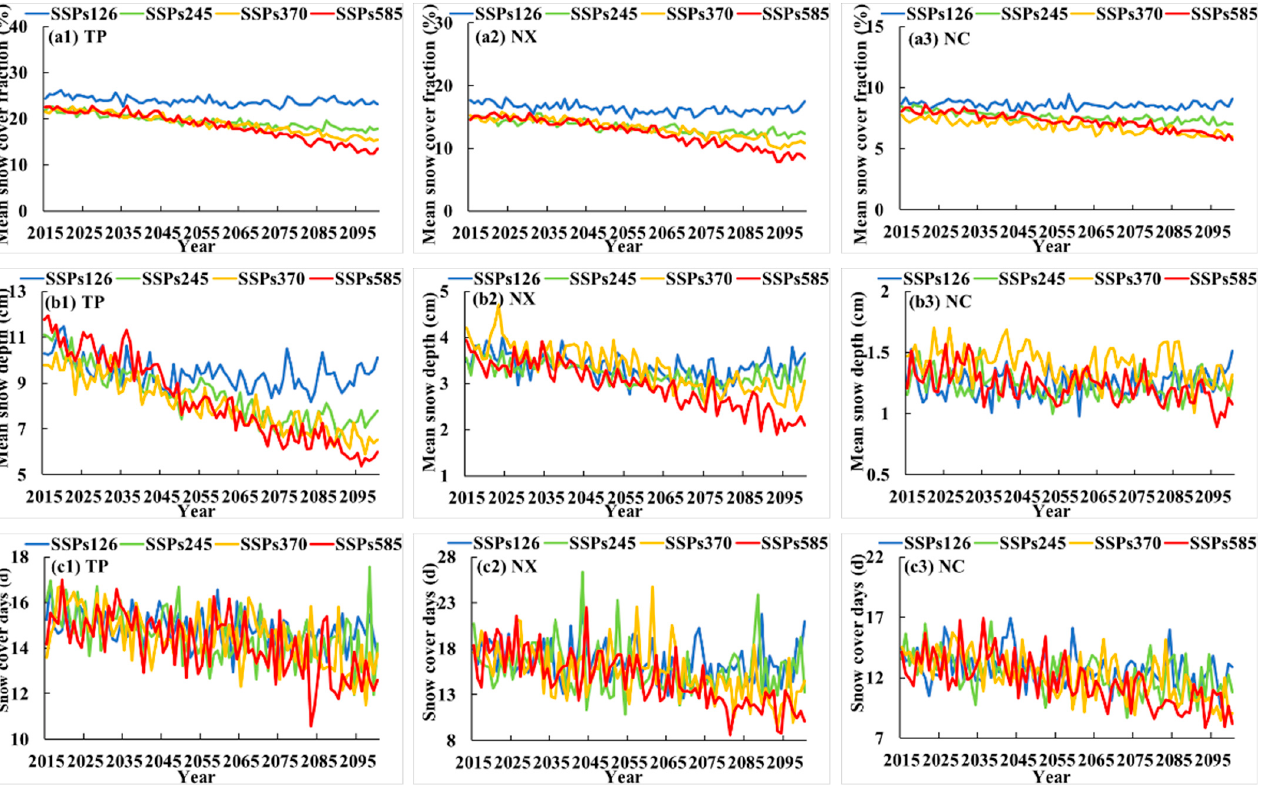
Figure 8. Annual variations in the SCF ( a ), SD ( b ), SCDs ( c ) in the TP ( a1 – c1 ), NX ( a2 – c2 ), and NC ( a3 – c3 ) under SSP scenarios from 2015 to 2100. The blue line represents SSPs126, the green line represents SSPs245, the yellow line represents SSPs370, and the red line represents SSPs585.